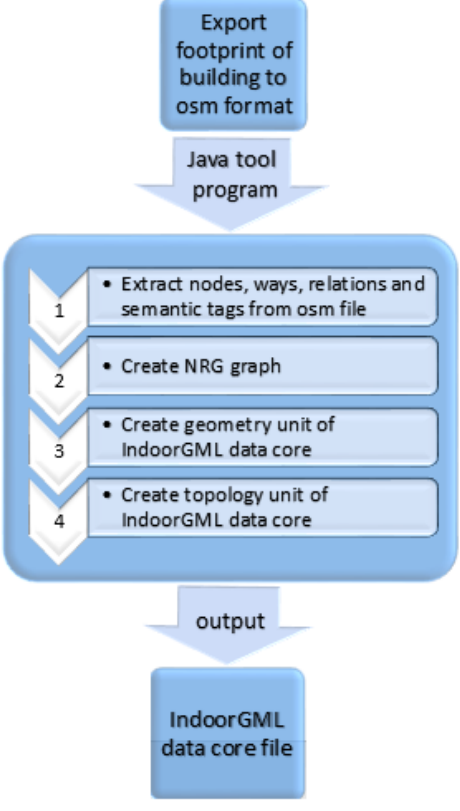
Figure 4. Proposed